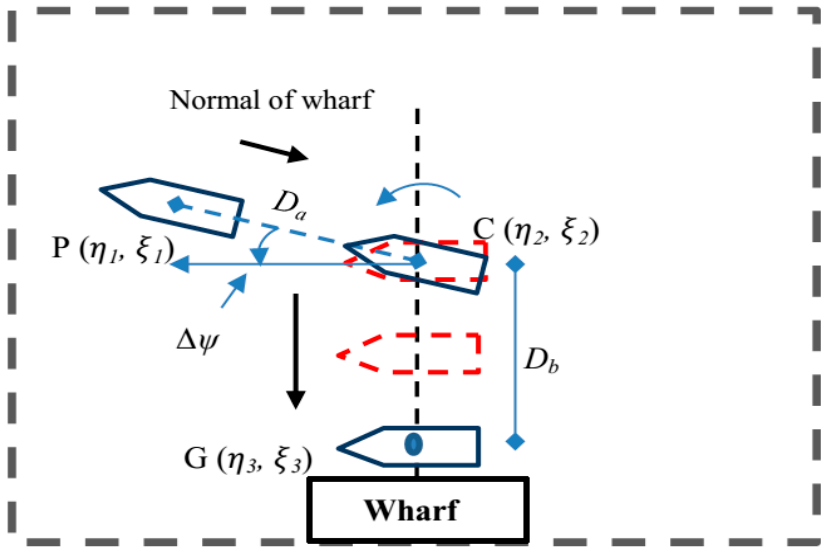
Figure 3. The parameters used in this system.